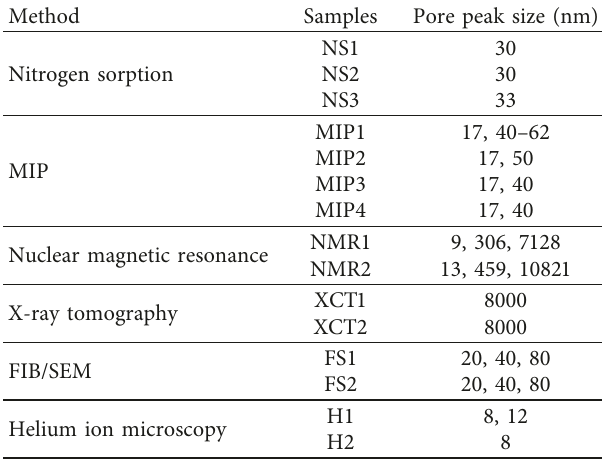
Figure 7: Raw images and segmented porous volume of hardened cement paste by HIM: (a) original images of H1; (b) segmented porous volume of H1; (c) cropped area 1 of H1; (d) segmented cropped zone 1 of H1; (e) cropped zone 2 of H1; (f) segmented cropped area 2 of H1; (g) original images of H2; (h) segmented porous volume of H2. Table 4: Peak size of porous volume by multiple